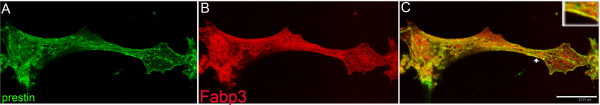
Co-localization of prestin and Fabp3 in OK cells. OK cells were transiently co-transfected with GFP-prestin and Xpres-tagged Fabp3. After 48 hrs, cells were fixed and incubated with mouse anti-Xpress followed by the corresponding secondary antibody. Yellow image (C) is superimposed from green prestin (A) and red Fabp3 (B) images, indicating the co-localization of prestin and Fabp3. For better visualization of the co-localization, the demarcated portion (indicated by arrowhead) of panel C is shown in the left corner of panel. Bar: 23.8 μm.